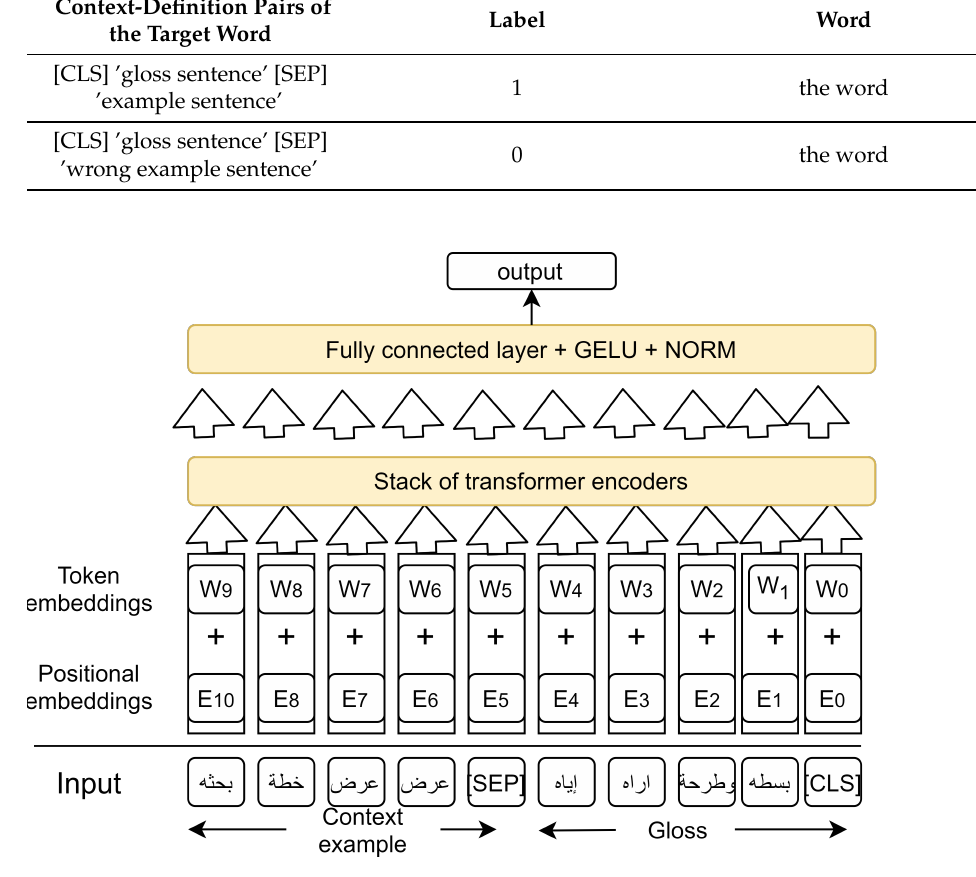
Figure 6. Model II